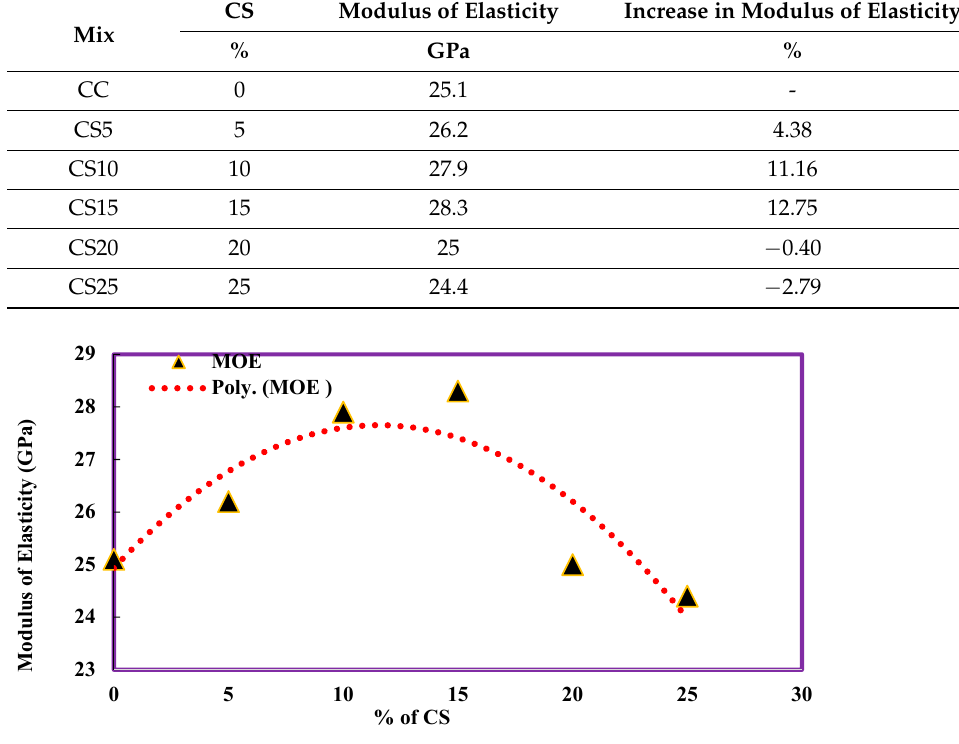
Figure 7. Modulus of elasticity of CS Concrete.